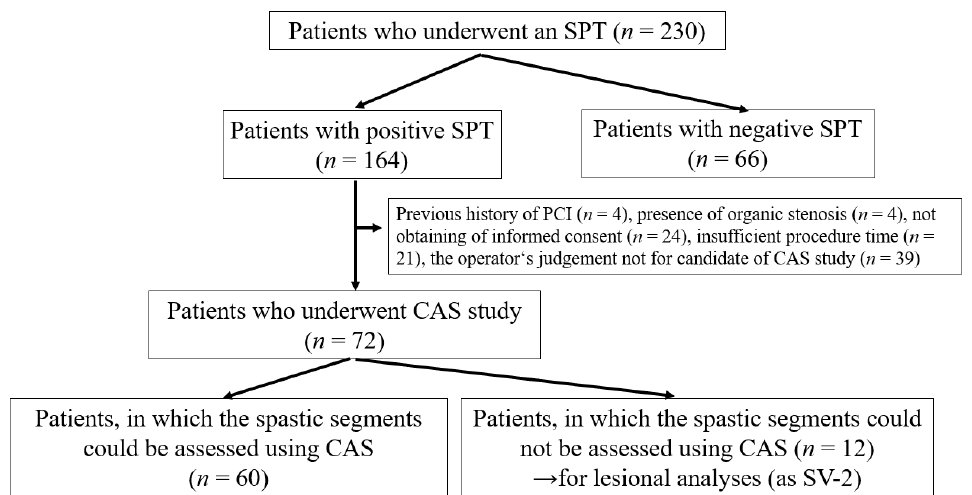
Figure 1. Study flowchart showing the retrospective enrolment of patients with positive SPT who underwent CAS. CAS, coronary angioscopy; SPT, spasm provocation test. We sometimes experienced difficulties discriminating the intracoronary thrombus and not-eliminated blood flow, as mentioned in the ‘Methods’ section.